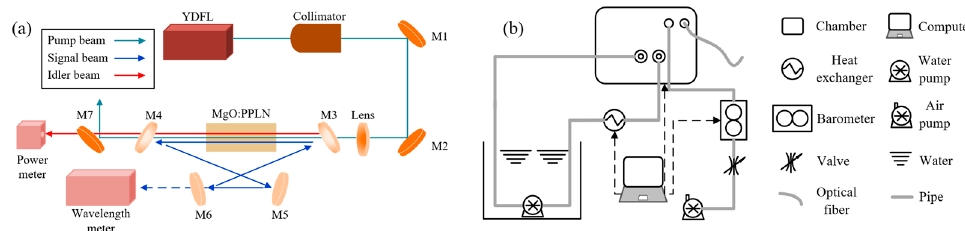
Figure 1. ( a ) Experimental setup for four-mirror ring cavity and ( b ) experimental setup for water cooling and pressure controlling.